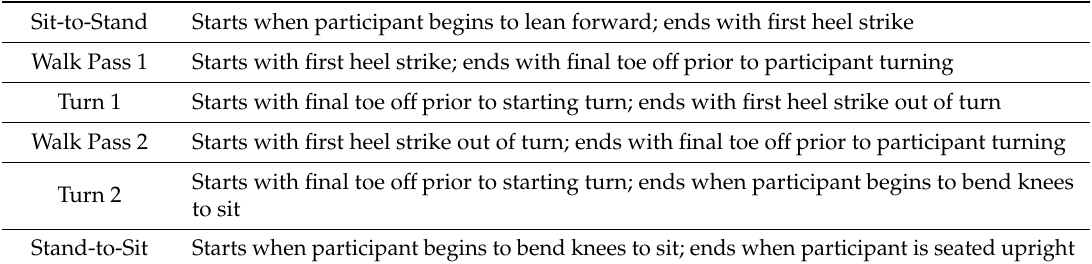
Table 3. Description of TUG